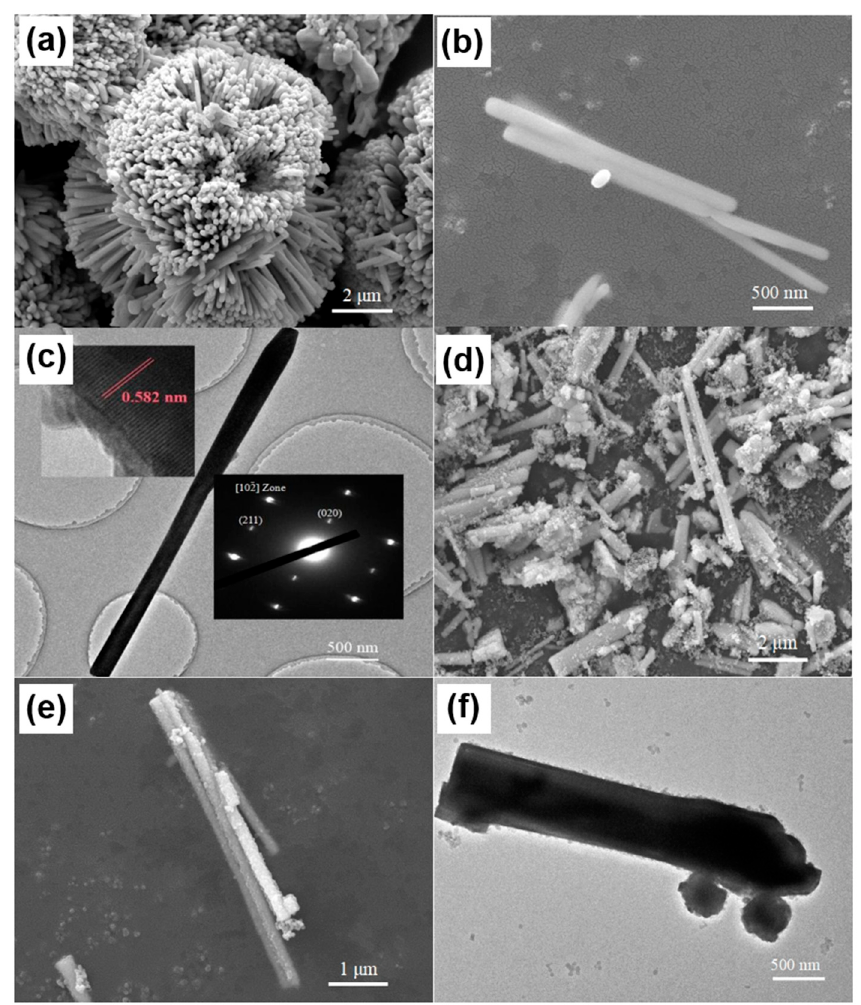
Figure 2. Morphology and structure characterization of BiVO 4 and BiVO 4 @ZIF − 8. Typical SEM images of as-synthesized BiVO 4 precursor at ( a ) low and ( b ) high magnification; typical ( c ) TEM image with HR-TEM and SAED images inserted of as-synthesized BiVO 4 precursor with the length of ~3000 nm and width of ~150 nm; typical SEM images of as-synthesized BiVO 4 @ZIF − 8 at ( d ) low and ( e ) high magnification; ( f ) typical TEM image of as-synthesized BiVO 4 @ZIF − 8 with the ZIF − 8 nanoparticles tightly attached to the surface of the BiVO 4 nanorod.